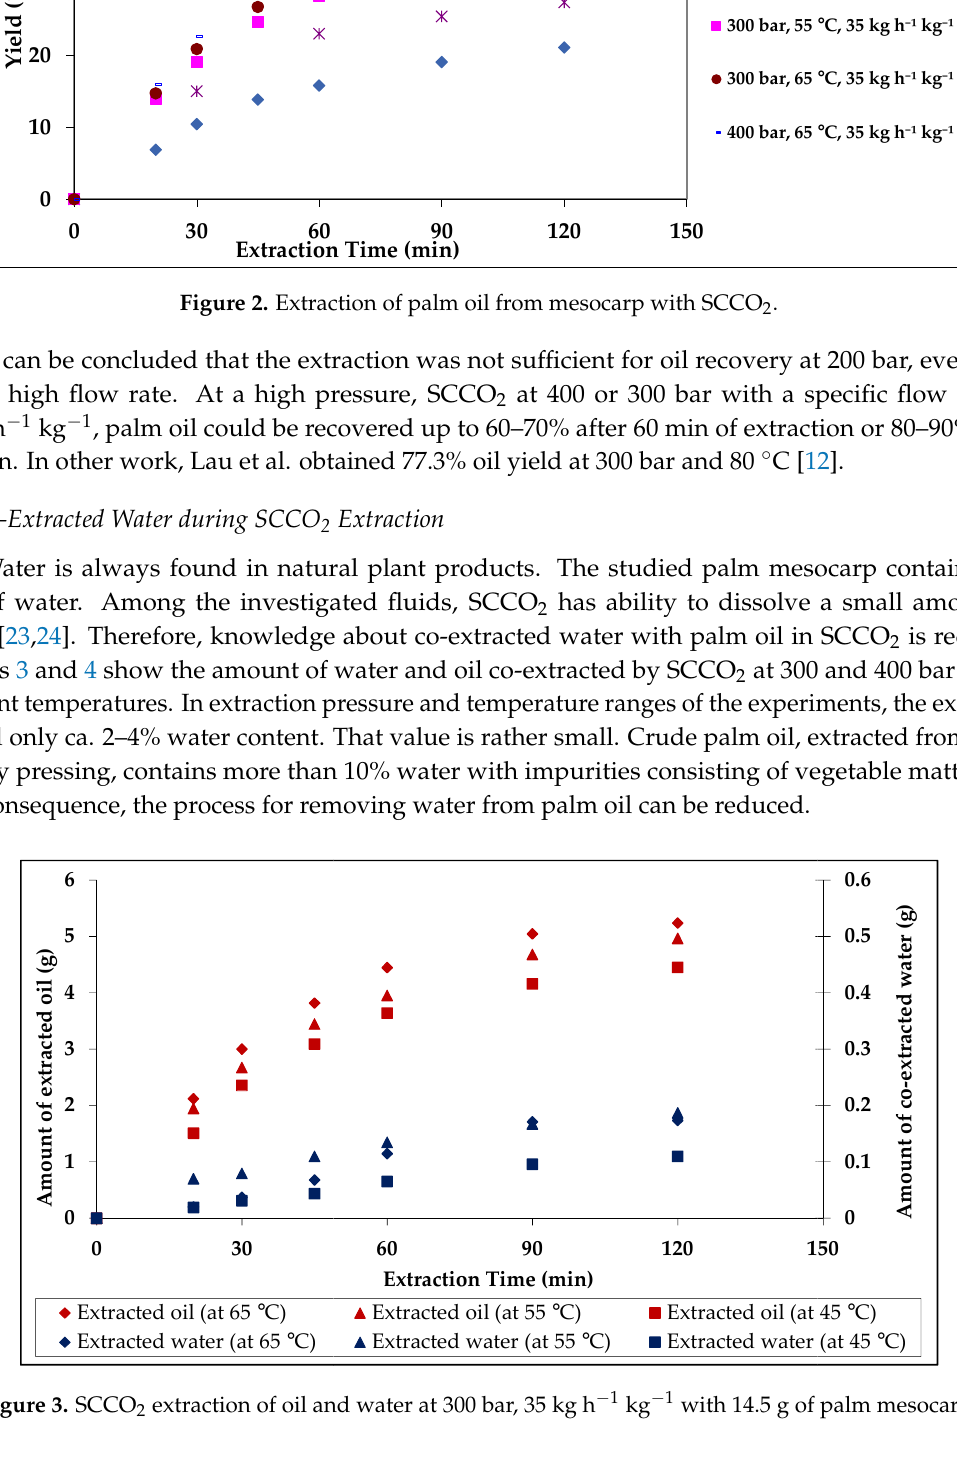
− 1 kg − 1 with 14.5 g of palm